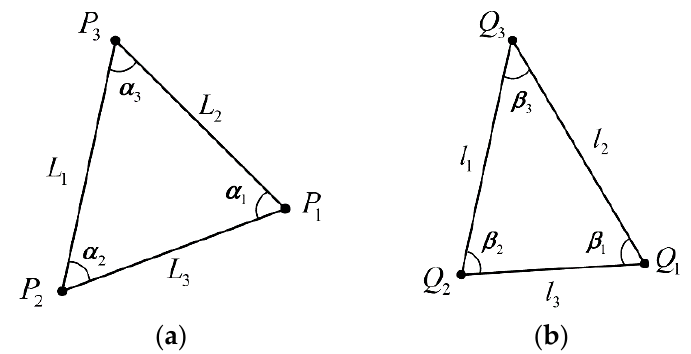
Figure 7. ( a ) The undeformed unit; ( b ) the deformed